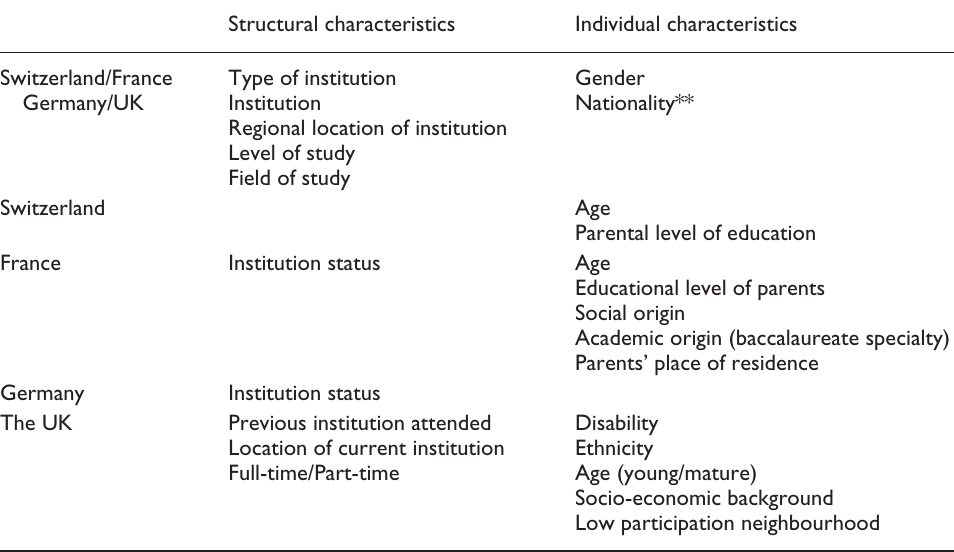
Table 2. Comparative framework for reading indicators of inequalities concerning access* to higher education in Switzerland, France, Germany and the UK. Structural